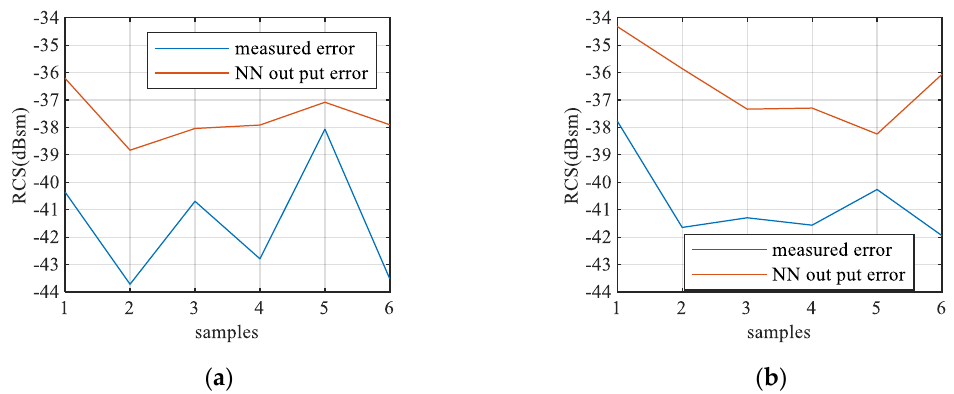
Figure 14. Measurement and neural network error (NN without optimization): ( a ) RMSE of each sample for 25 mm (0.83λ) diameter sphere; ( b ) RMSE of each sample for 45 mm (1.5λ) diameter sphere.